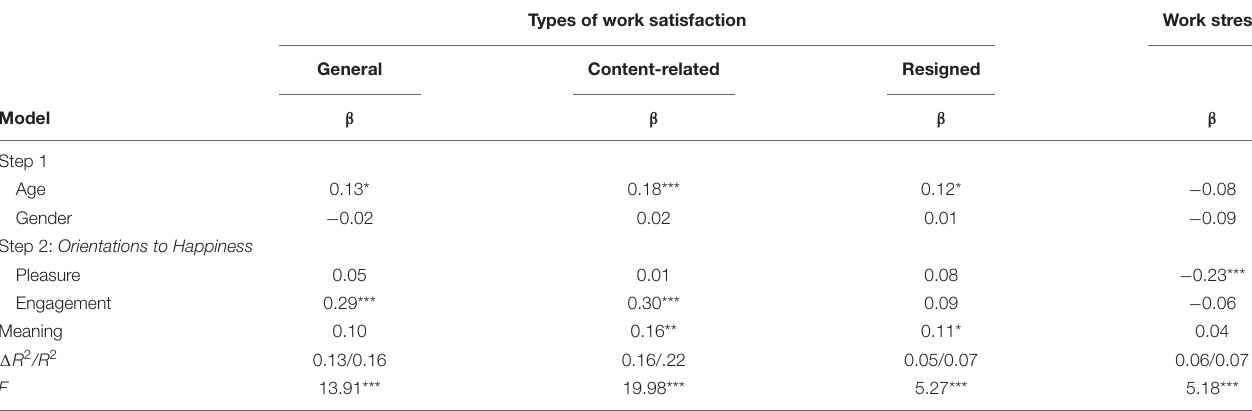
TABLE 2 | Hierarchical multiple regression analyses predicting types of work satisfaction (general, content-related, resigned) and work stress from age, gender, and orientations to happiness (pleasure, engagement,